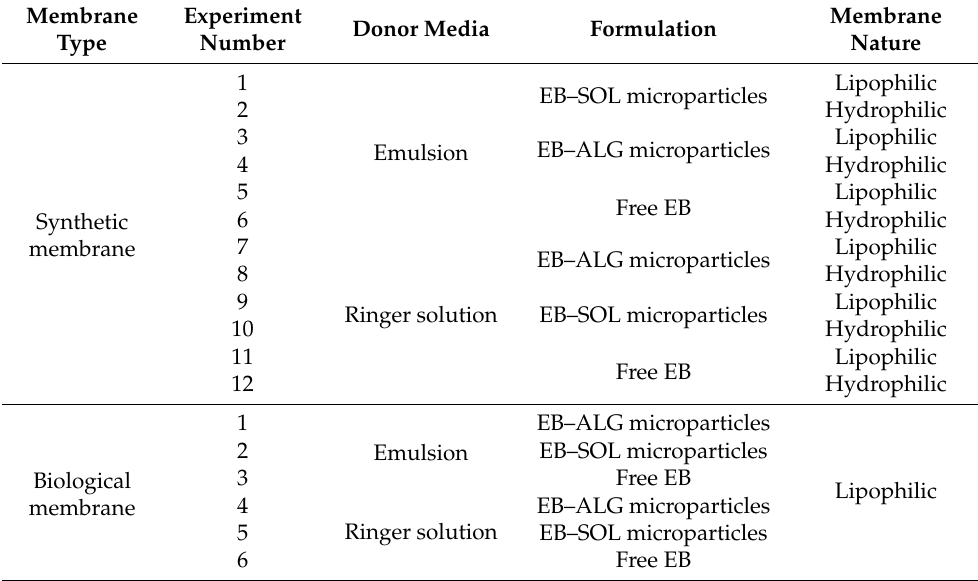
Table 6. Experimental design of synthetic membranes and biological